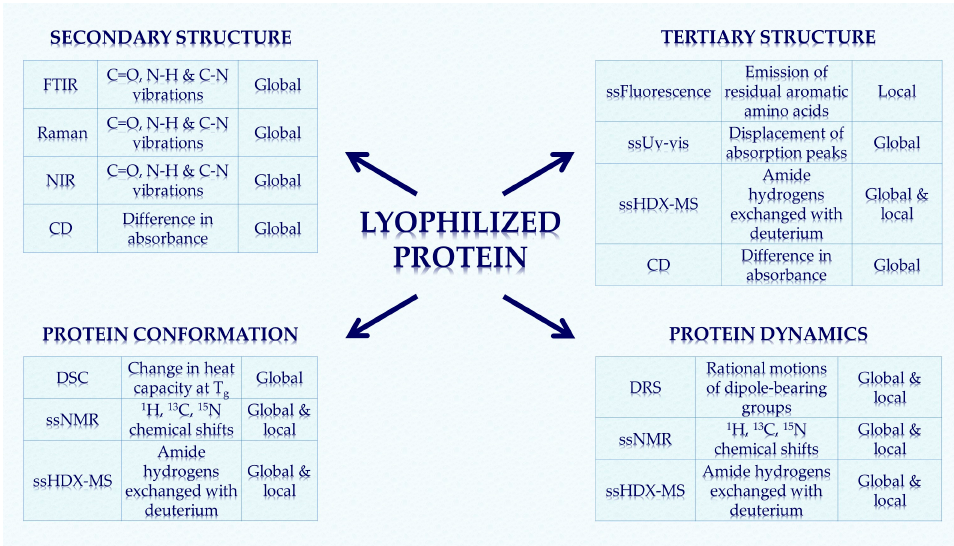
Figure 1. The most common analytical techniques for the structural characterization of proteins in solid pharmaceutical forms are presented with corresponding type of measurements. Changes in secondary/tertiary structure and conformation can be studied on a global and local scale. Protein dynamics can also be traced using some of the above methods. FTIR—fourier transform infrared; NIR—near-infrared; CD—circular dichroism; ss—solid-state, HDX-MS—hydrogen-deuterium exchange mass spectrometry; DSC—differential scanning calorimetry; NMR—nuclear magnetic resonance; DRS—dielectric relaxation spectroscopy.